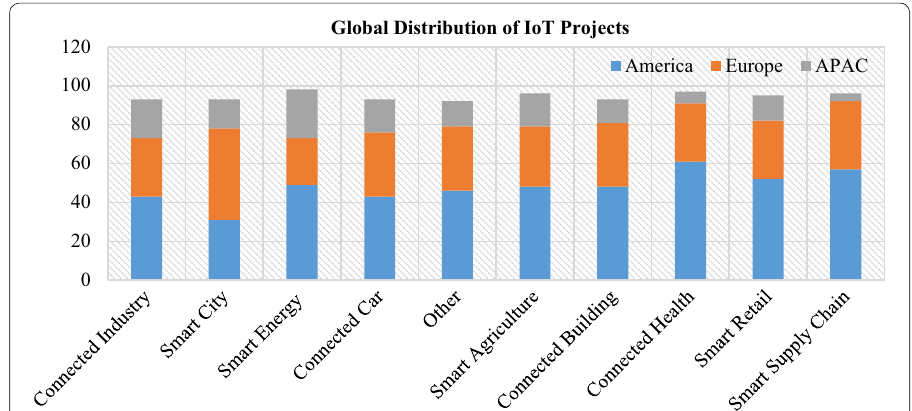
Fig. 3 Global distribution of IoT projects among America (USA, South America and Canada), Europe and APAC (Asia and Pacific region) [8]